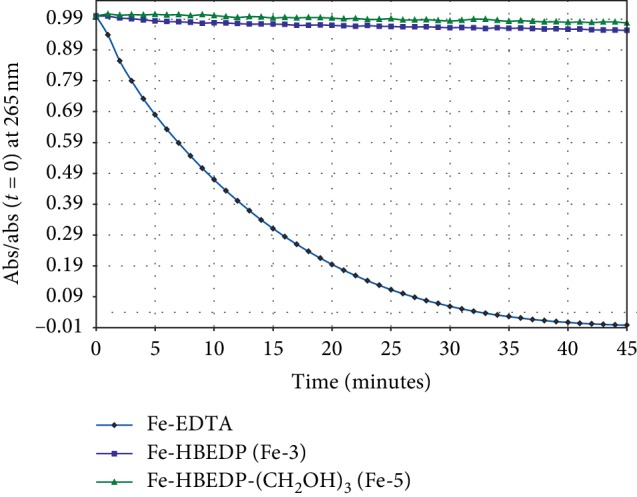
Air oxidation of ascorbic acid catalyzed by Fe-3 and Fe-5 and positive control Fe-EDTA.